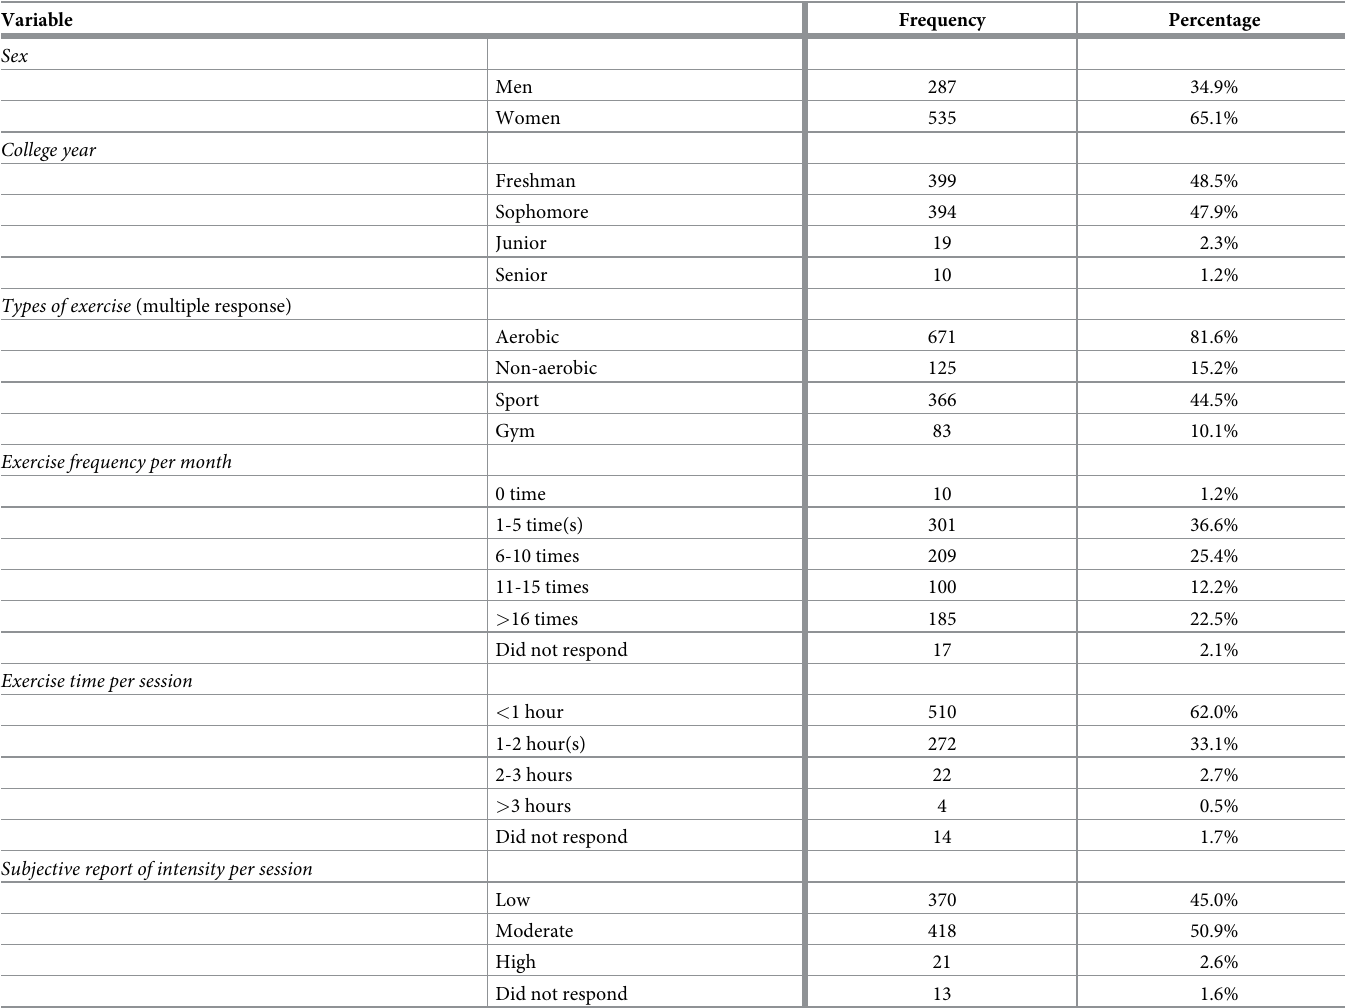
Table 1. Background information for the participants ( N =